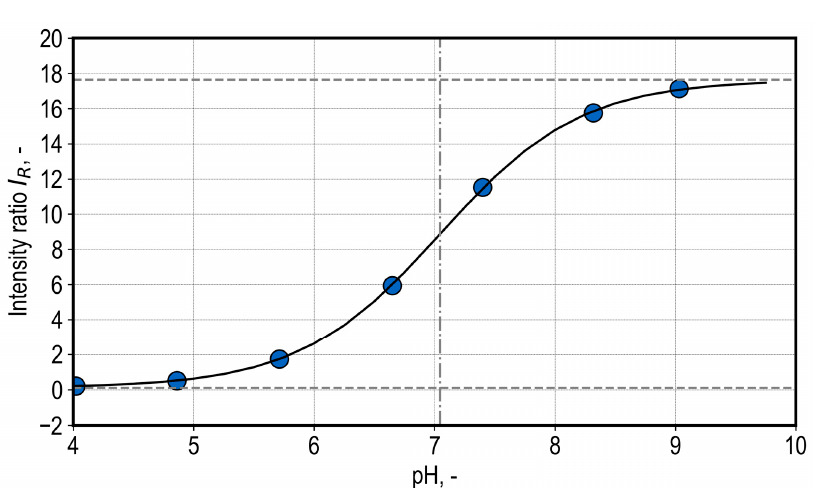
Figure A1. Calibration curve of a microplate with integrated chemical optical pH sensors (intensity ratio I R as function of pH). The sensors are read from the bottom using a fluorescence reader with wavelengths of 485/540 nm and 485/620 nm. I R was measured in triplicate (standard deviation <1%). The calibration is valid for an artificial seawater (ASW) medium at room temperature. Identified correlation parameters: I min = 0.115; I max = 17.635; pH 0 = 7.048; dpH = 0.582. I min and I max represent the horizontal asymptotes of the sigmoidal calibration curve (--), pH 0 is the inflection point (-.), and dpH affects the curve width.